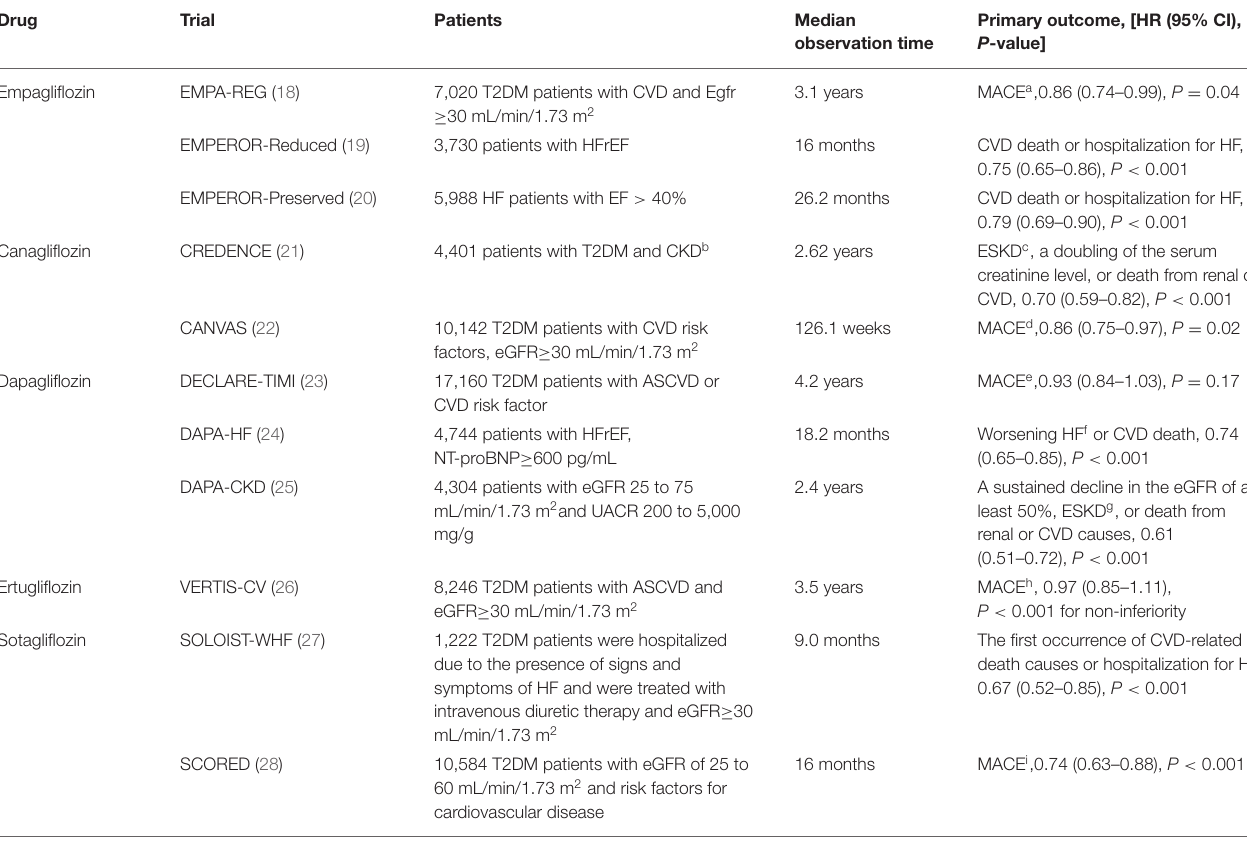
TABLE 1 | Large clinical trials of SGLT2 inhibitors.